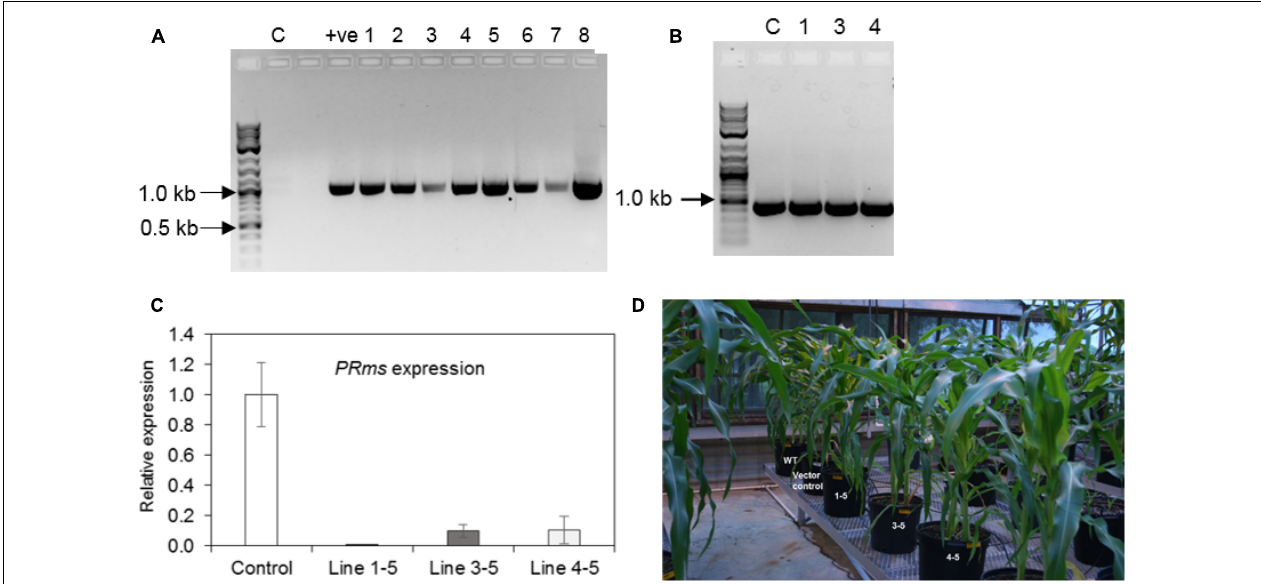
FIGURE 2 | Confirmation of maize transgenic plants and plant phenotype. (A) Genomic DNA isolated from ZmPRms– RNAi lines and control plant were used to amplify a 1156 bp DNA fragment to confirm the presence of the RNAi cassette (C = empty vector transformed control plants; +ve = plasmid vector used as a PCR template; NEB 2-Log DNA ladder user as a DNA marker); (B) Genomic DNA isolated from ZmPRms– RNAi and empty vector transformed control (C) plants were used to amplify a 433 bp diagnostic DNA fragment to confirm the presence of the ‘ Bar ’ plant selection marker gene (Line 1 = 1–5, Line 3 = 3–5, Line 4 = 4–5; NEB 2-Log DNA ladder user as a DNA marker); (C) Relative expression of the native PRms gene in the kernels of empty vector transformed control and PRms -RNAi maize lines at 7 days post inoculation (dpi) [Gene expression was normalized to the maize ribosomal structural gene GRMZM2G024838 (Shu et al., 2015); data are mean ± SE of 3–4 biological replicates]; (D) Plant growth phenotype (uninfected) of ZmPRms– RNAi lines as compared to the wild type (WT) or empty vector transformed control transgenic maize plants.